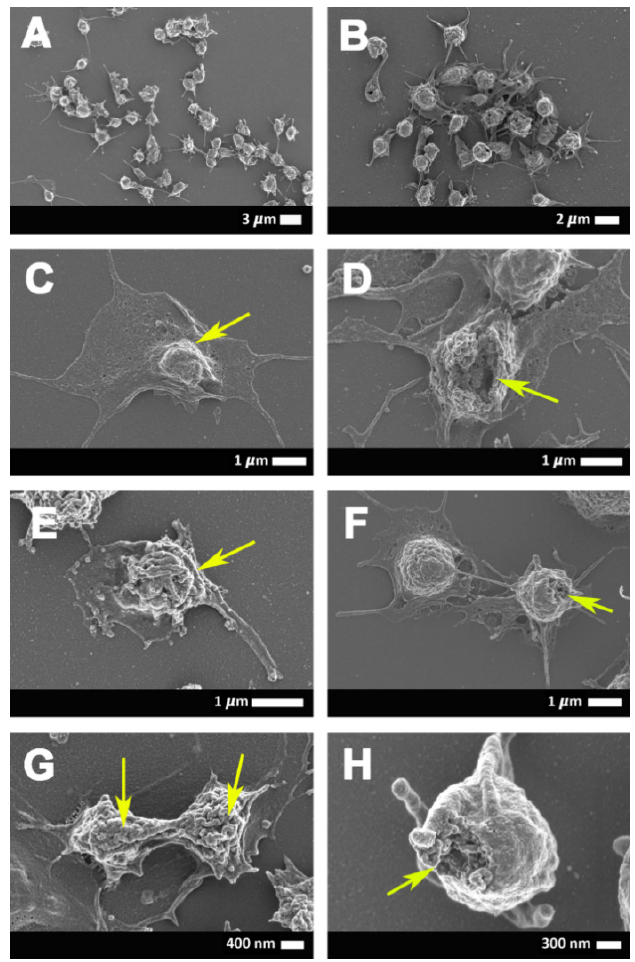
Figure 3. ( A – H ) Representative scanning electron micrographs of the platelet ultrastructure seen in COVID-19-positive patients. Yellow arrows show some platelet membranes damage that was observed.